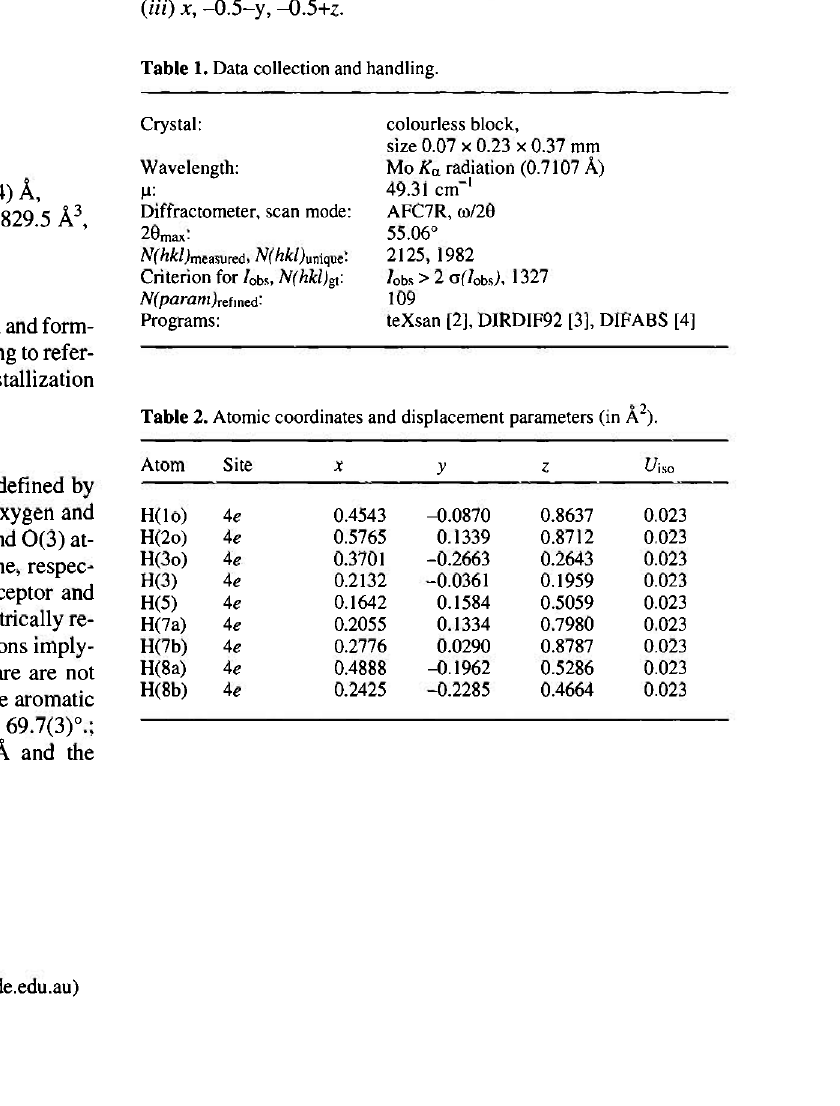
Table 1. Data collection and handling.